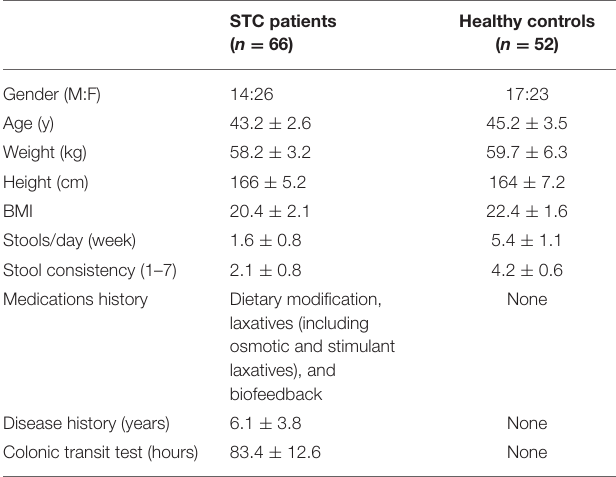
TABLE 1 | Characteristics of patients with slow transit constipation (STC) and healthy controls.